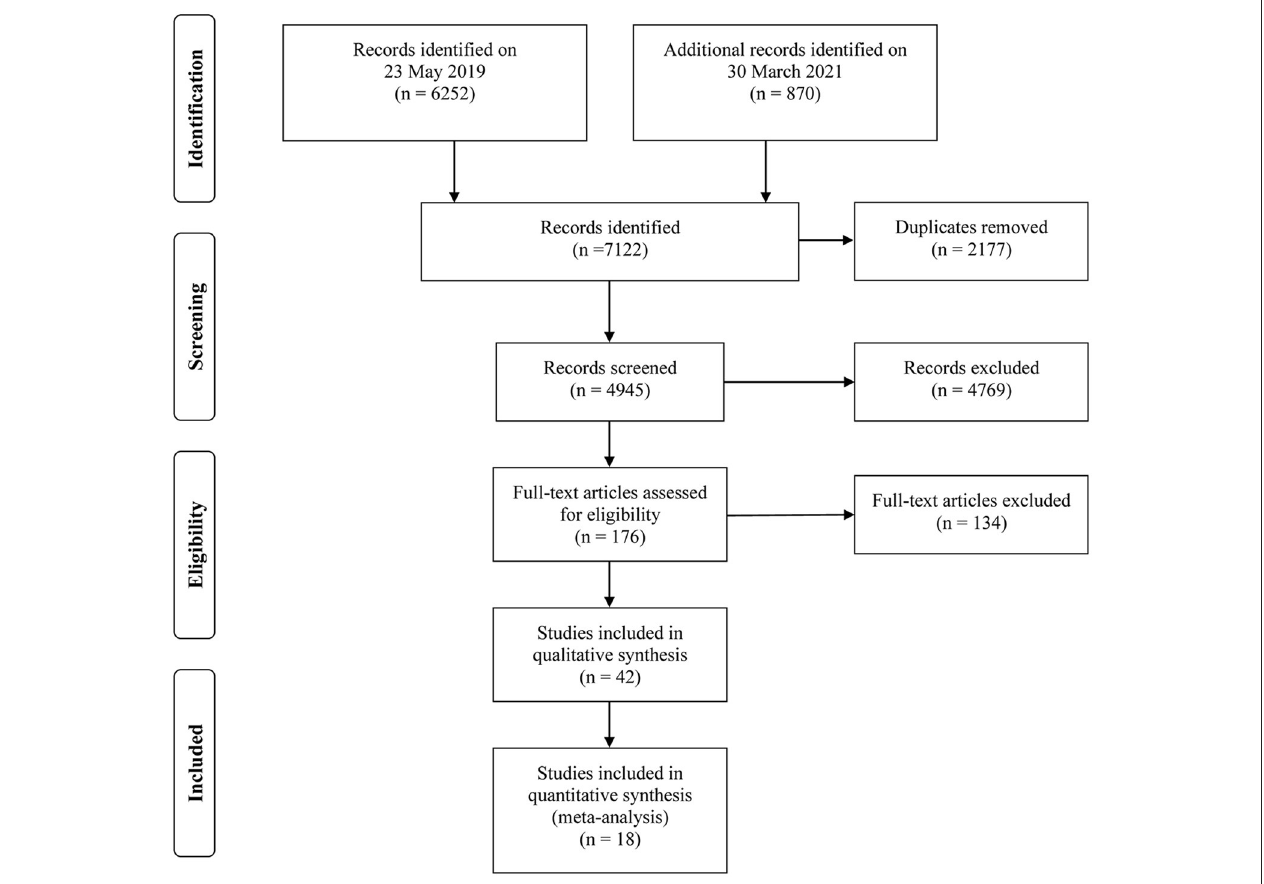
FIGURE 1 | The PRISMA flow diagram of study